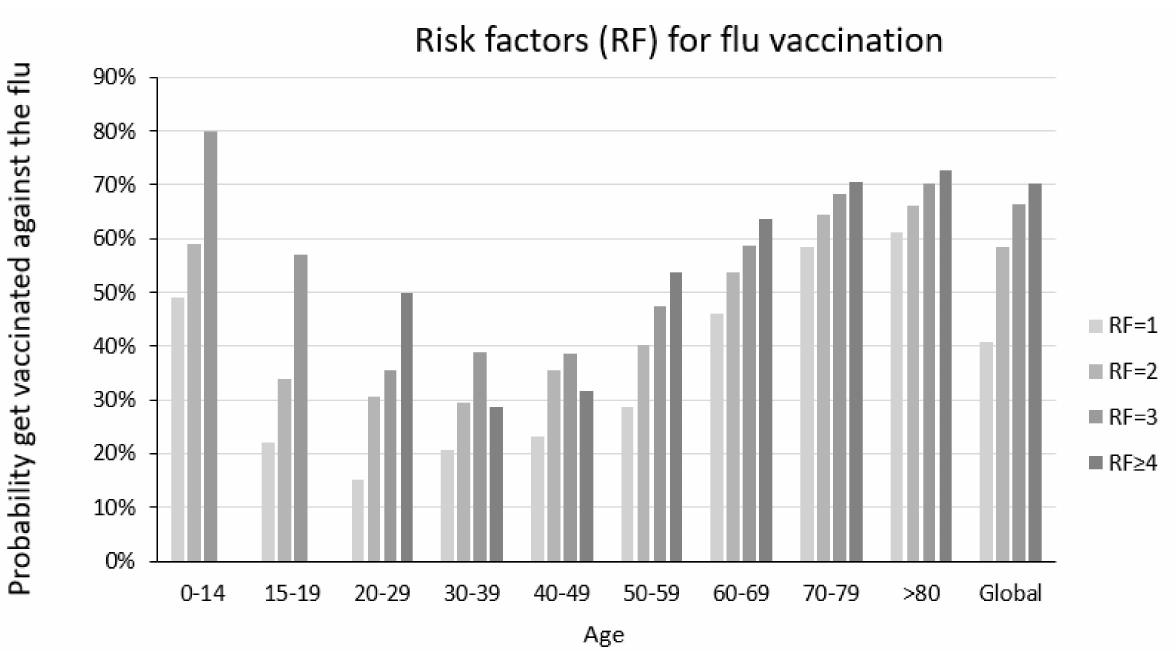
Figure 2. Proportion of people vaccinated against flu according to age and the number of risk factors for flu complications. When the relative risk of contracting COVID-19 was examined in relation to the various risk factors for flu complications (Table 3), the differences observed were not statistically significant for most factors. For those factors that did show significant effects, the differences were small and not clinically significant. Statistically significant differences were observed for patients with chronic cardiovascular diseases, diabetes mellitus and lung and kidney problems; these patients account for 80% of the sample. When stratifying by age, in each one of these groups no differences are observed between those vaccinated and those not vaccinated against flu Table 3. Percentage of people contracting COVID –19 according to whether they had been vaccinated for flu (FVS). p -value of the proportion comparison